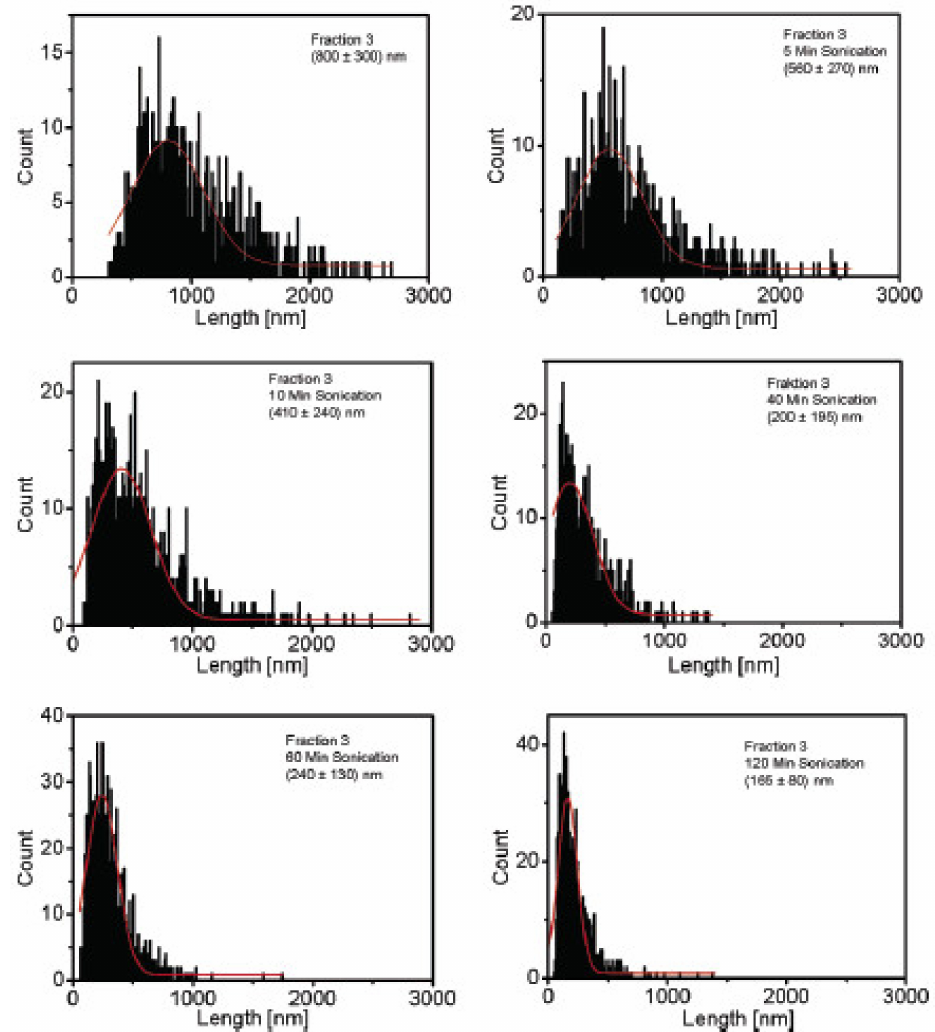
Figure 12. Shortening of SWCNT by sonication. The shift of the length distribution to smaller values and the narrowing down of the length distribution is visible. Reprinted with permission from [36], Copyright (2007) American Chemical